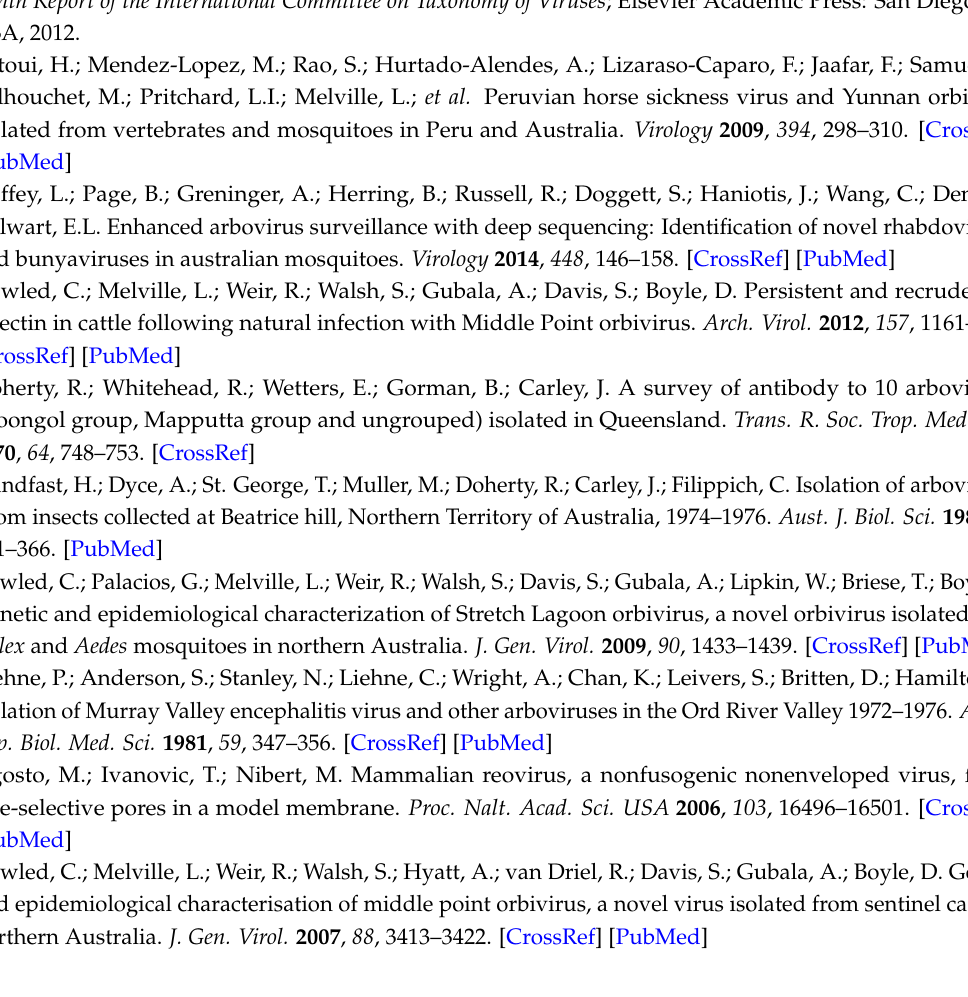
Figure S1: Phylogenetic analysis of truncated orbivirus highly conserved T13